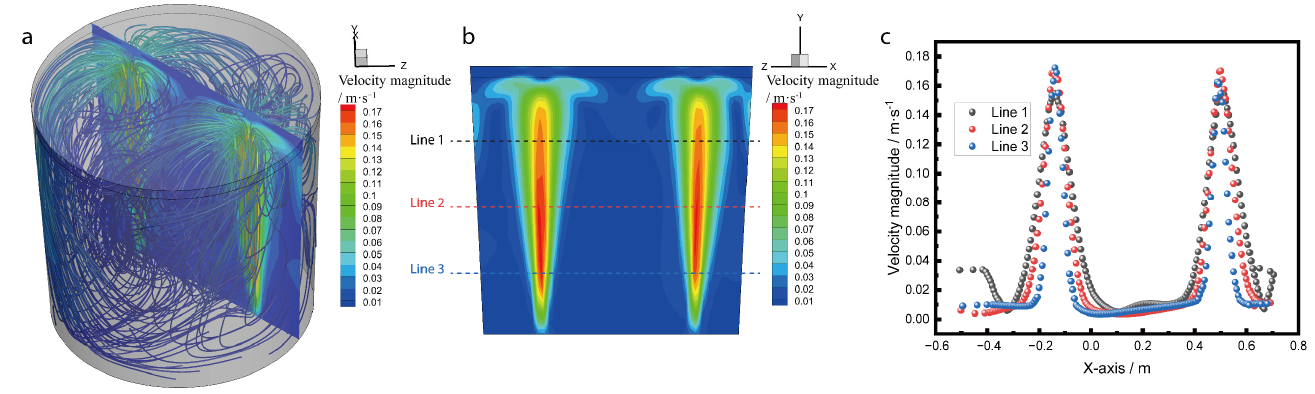
Figure 8. The prototype numerical simulation results: ( a ) streamline results and slice contour position, ( b ) velocity contour at the slice position, and ( c ) velocity magnitude results at three lines.